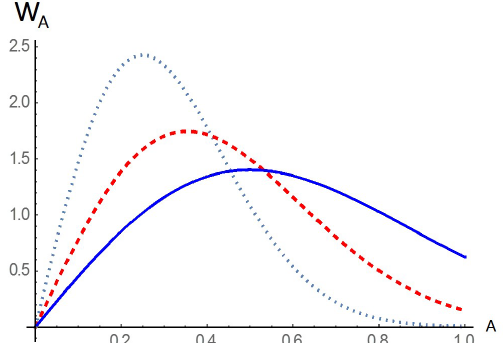
Figure 5. The modified Rayleigh distribution (Eq. 43) for different distribution values A s /A max (0.5: the dotted curve; 0.7: the dashed line; 1: the solid